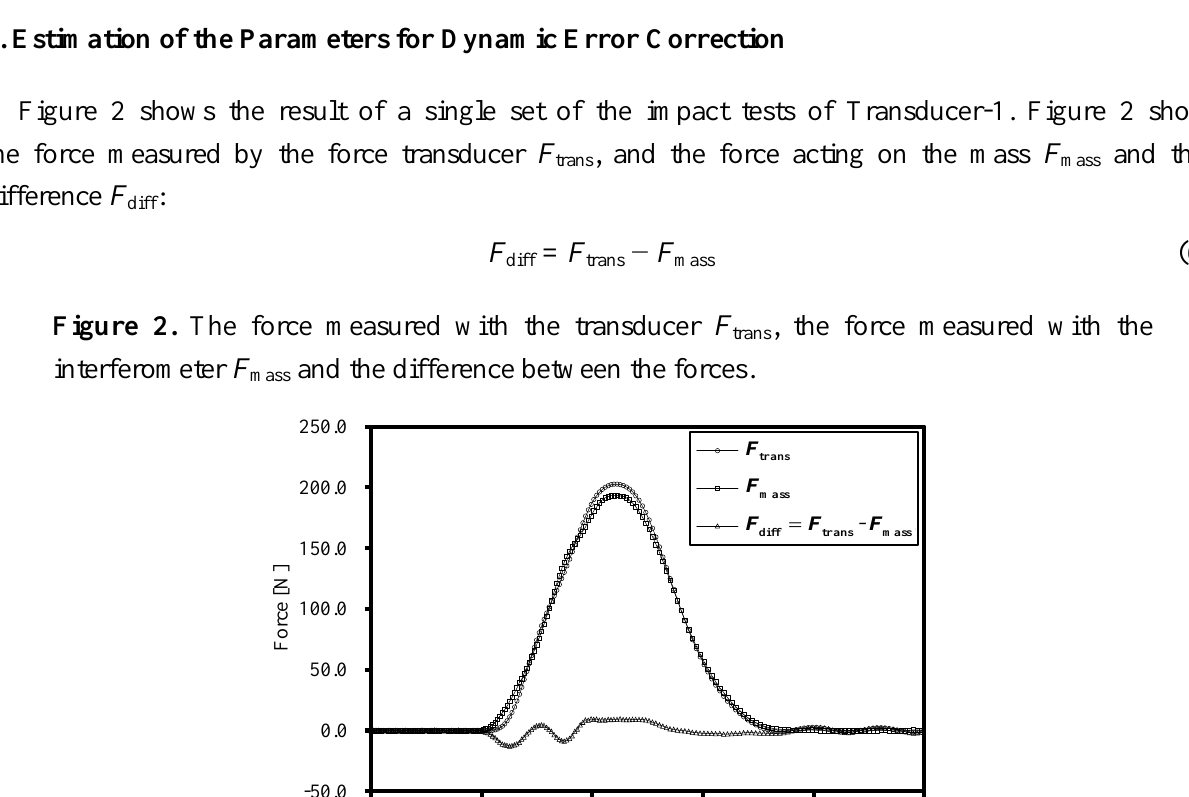
Figure 3. Relationship between the differential coefficient of the second order of the force measured with the transducer and the difference between F